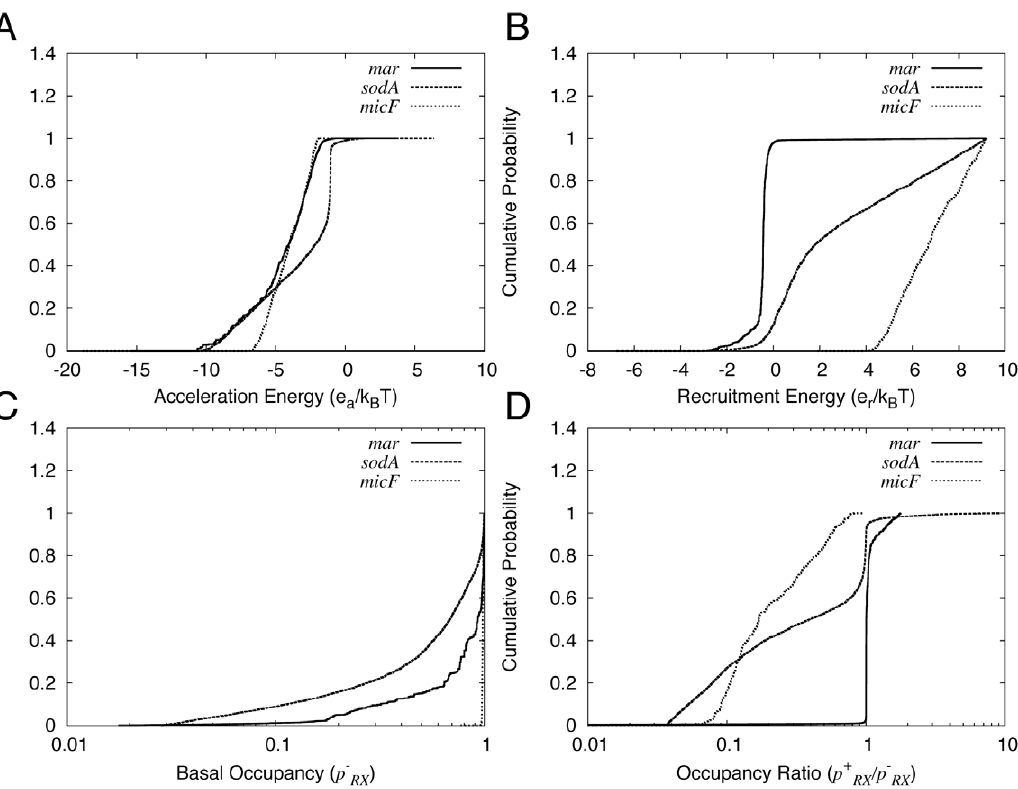
Figure 4. Cumulative probability distribution functions used to interpret the modeling results. The panels show plots of C ( x ), where the x -axis corresponds to A) acceleration energy; B) recruitment energy; C) basal occupancy of polymerase at the promoter; and D) polymerase occupancy ratio in the presence vs. absence of MarA. Results for marRAB (solid line), sodA (dashed line), and micF (dotted line) are plotted together in each